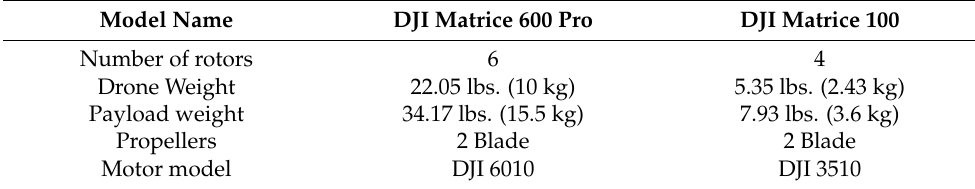
Table 1. Specification of the DJI Matrice